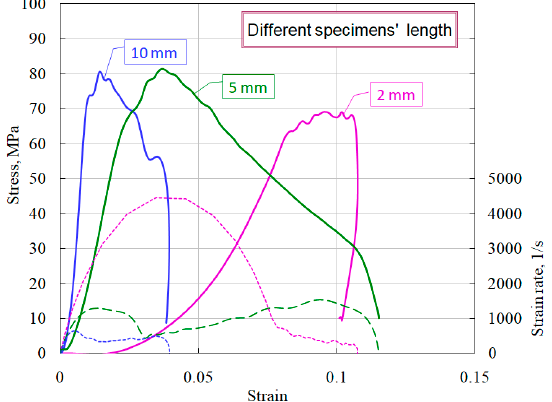
Figure 10. Effect of specimens’ length on ceramic properties.